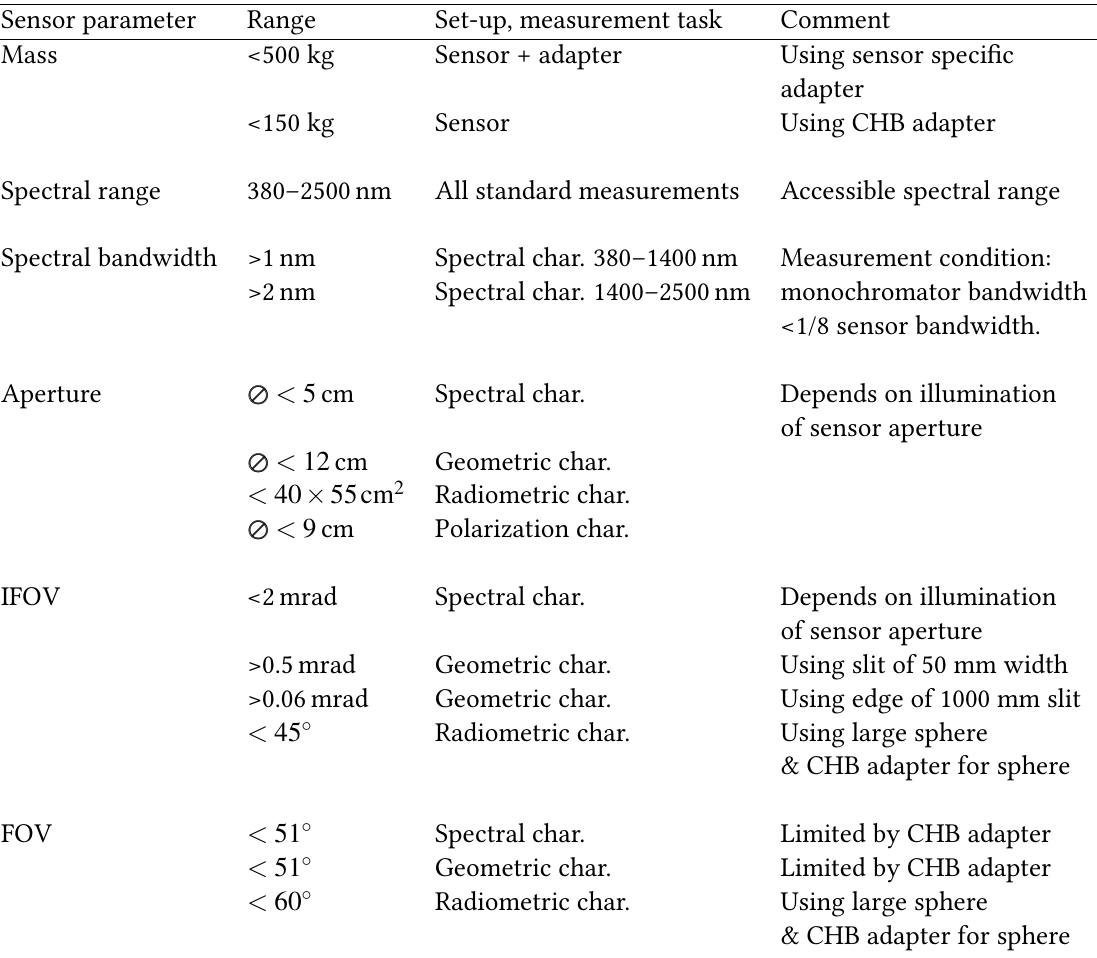
Table 1: Required specifications for pushbroom